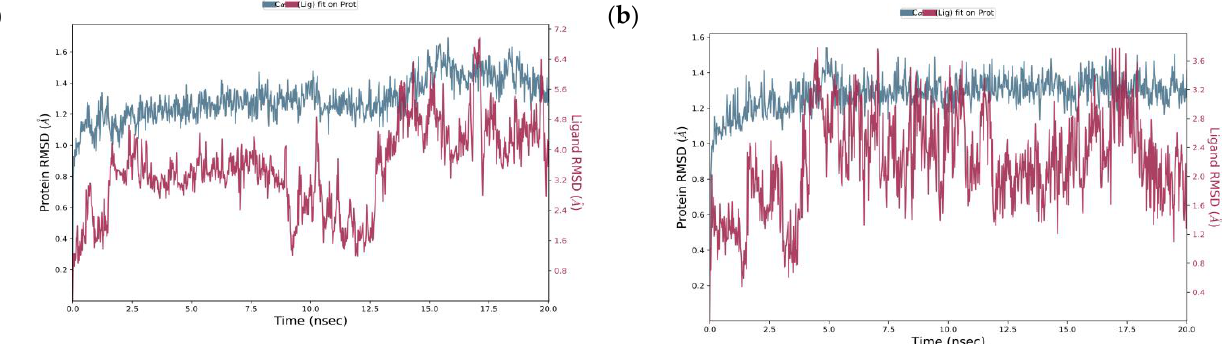
( b ) Figure 4. Root mean square fluctuation (RMSF) plotting (blue line) of: ( a ) acarbose and ( b ) naringenin, with specific residues of α -glucosidase (green line) during 20 ns simulation. To analyze the interaction of the ligand-receptor on the catalytic sites, the green line on the RMSF plots was used to represent the specific amino acids that interact with the compounds. Acarbose has 32, while naringenin has only 21 interactions with numerous specif ic amino acids in the α -glucosidase active site. This result showed that acarbose interacts with more amino acids than naringenin, which implies an improvement in the stability of the acarbose – glucosidase complex. Acarbose was found to interact with the catalytic sites ASP203, ASP327, and ASP542 with RMSF values of 0.531 Å , 0.424 Å , and 0.591 Å , respectively. Meanwhile, naringenin barely interacted with ASP 327 and merely with ASP203 (0.598 Å ) and ASP542 (0.528 Å ) along 20 ns of simulation time. This result suggests that naringenin is also stable when interacting with catalytic sites, as indicated by the lower RMSF value on the amino acid of ASP203 and ASP542, which represented minor conformational change. In the MD simulation, the stable complex system was analyzed for the type of protein- ligand interaction in 20 ns of simulation (Figure 5). The interaction with ASP203, ASP327, ILE328, and ASP443 was the most frequent interaction that could be maintained during the